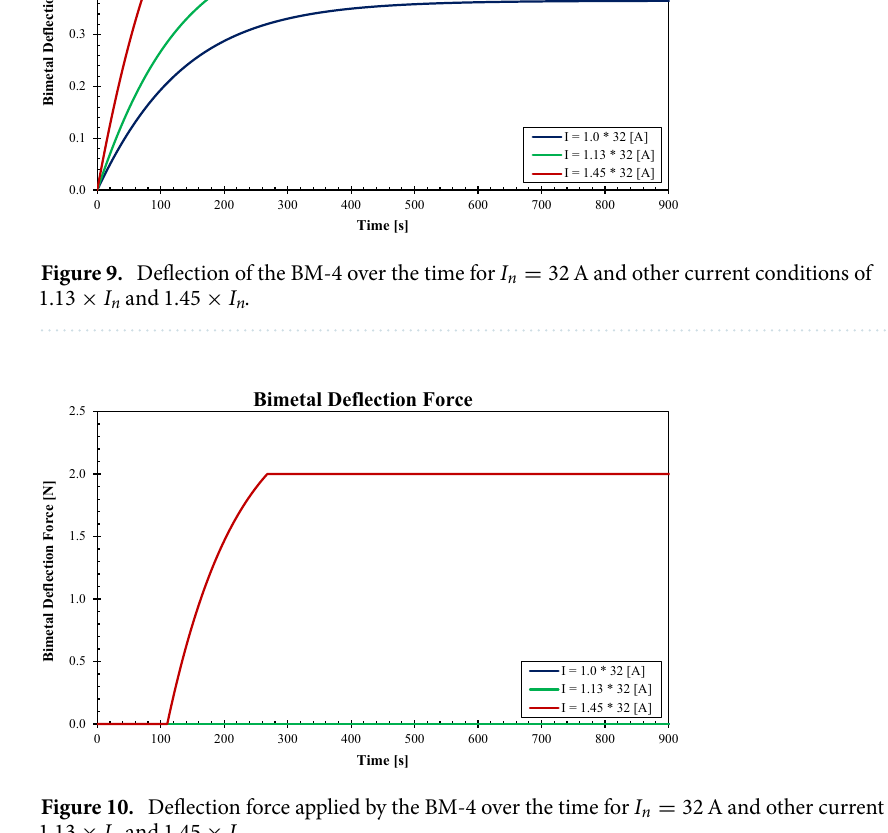
Figure 10. Deflection force applied by the BM-4 over the time for I n = 32A and other current conditions of 1.13 × I n and 1.45 × I n